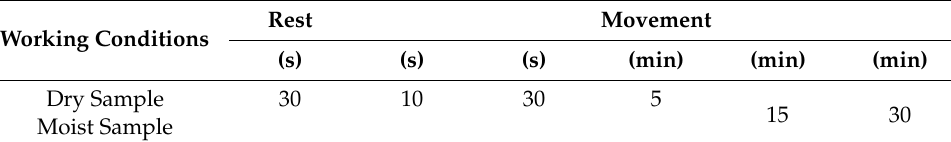
Table 2. Working conditions of friction node during the tests.